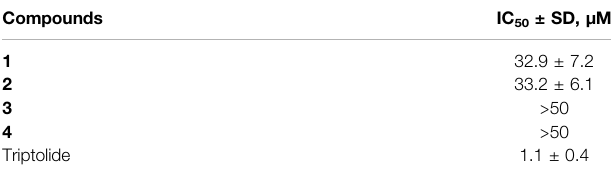
TABLE 2 | Antiproliferative activity of compounds 1 ‒ 4 against MV4-11 cell line. Compounds